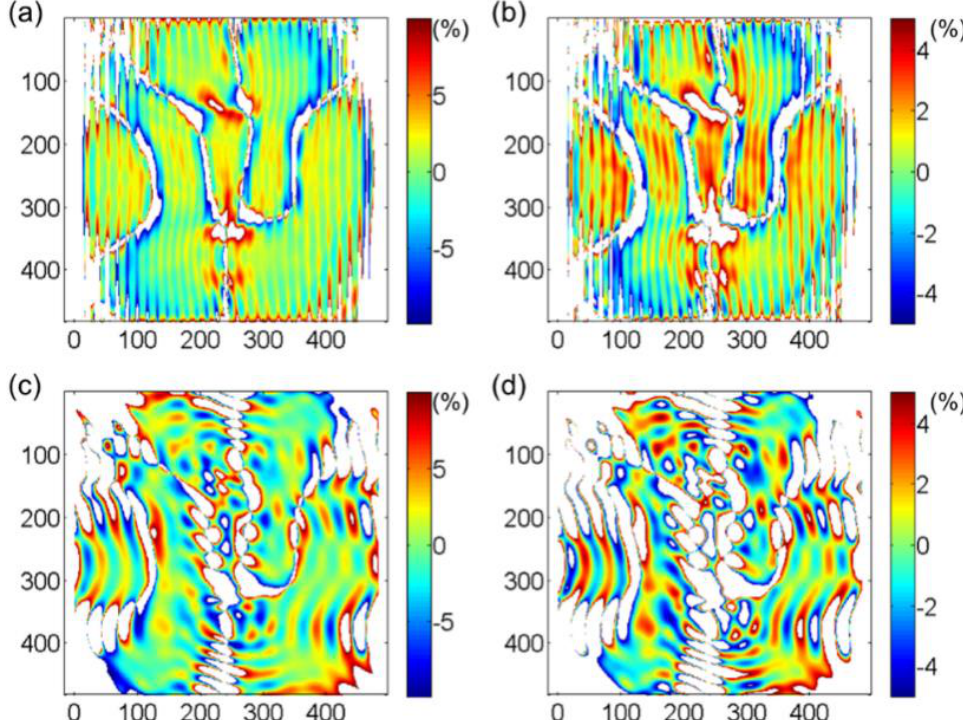
Figure 4. Strain error field calculated by S − GPA when the EPCR is ( a ) 10% and ( b ) 5%; Strain error field calculated by G − GPA when the EPCR is ( c ) 10% and ( d ) 5%.